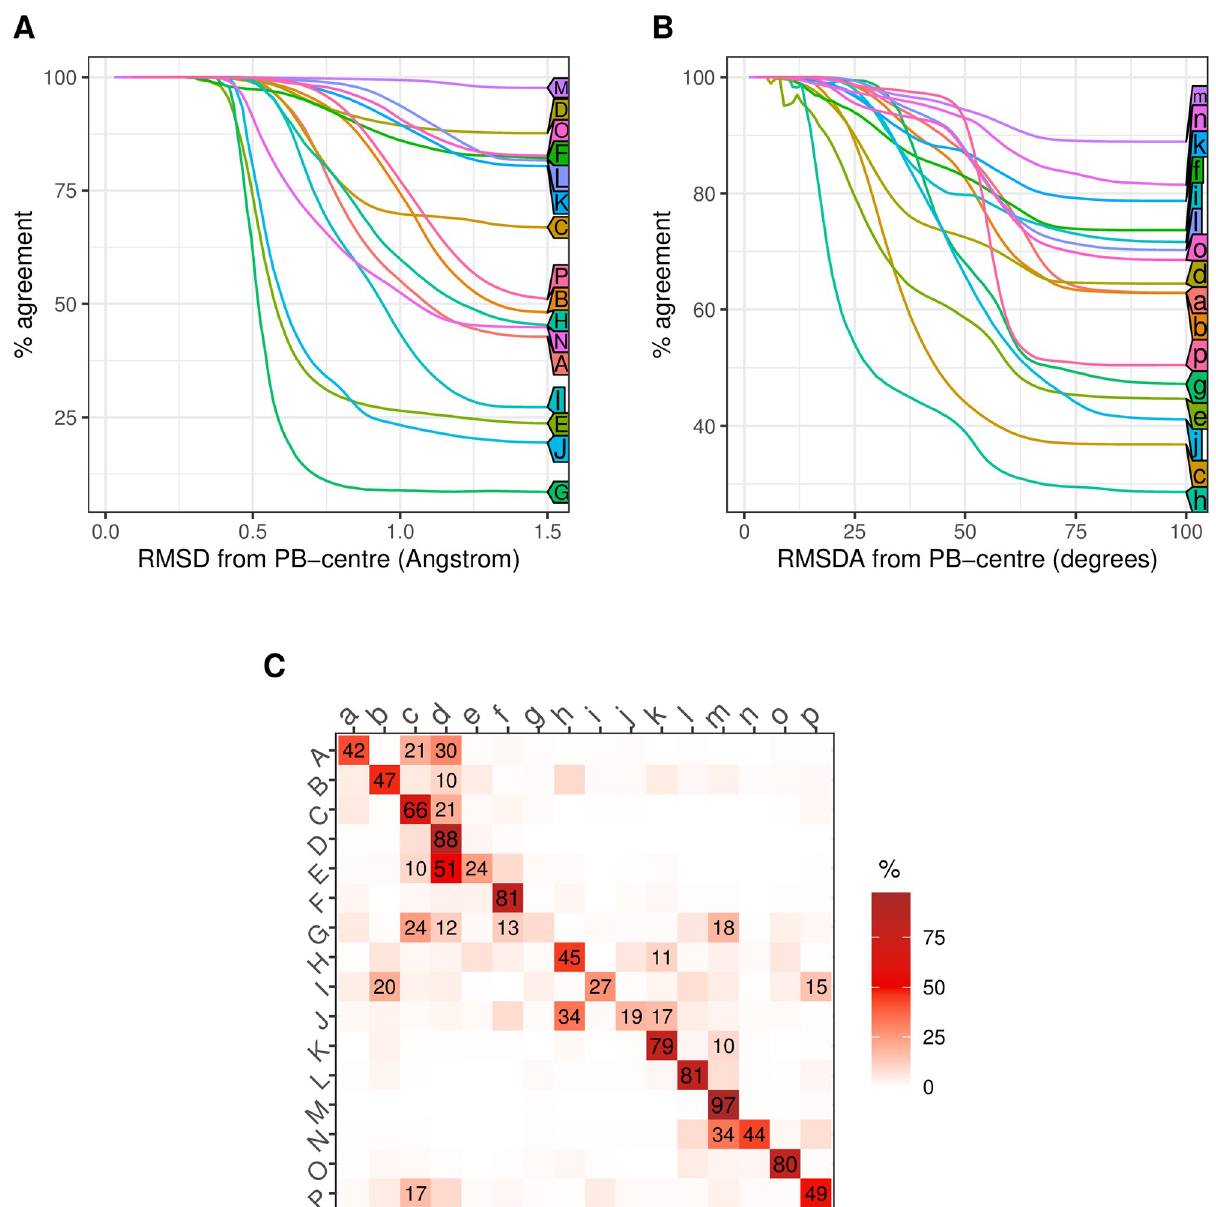
Fig 1. Relation between assignments based on RMSDA and RMSD. A shows the percentage (Y-axis) of matching RMSDA- and RMSD assignments among all the RMSD assignments for a given cluster that lie within a certain distance (X-axis) from the cluster centre, i.e. the corresponding protein block (PB); B shows the reverse of A, namely, the percentage of matching RMSDA- and RMSD assignments among all the RMSDA assignments for a given cluster that lie within a certain RMSDA-distance (X-axis) from the centre; C shows the percentage of matching assignment for each RMSD- cluster among all fragments. The full set of fragments for this investigation is PDB30 (see Methods for